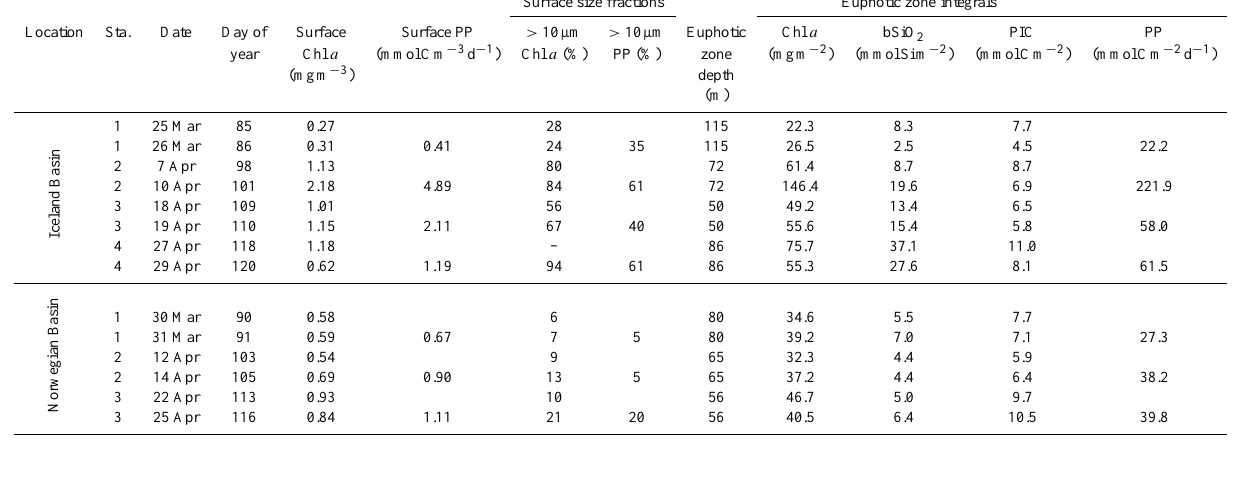
Table 2. Biological features of the Iceland Basin and Norwegian Basin stations: Sta., station; Chl a ; PP, primary production; bSiO 2 , particu- late silicate; PIC. Location Sta.